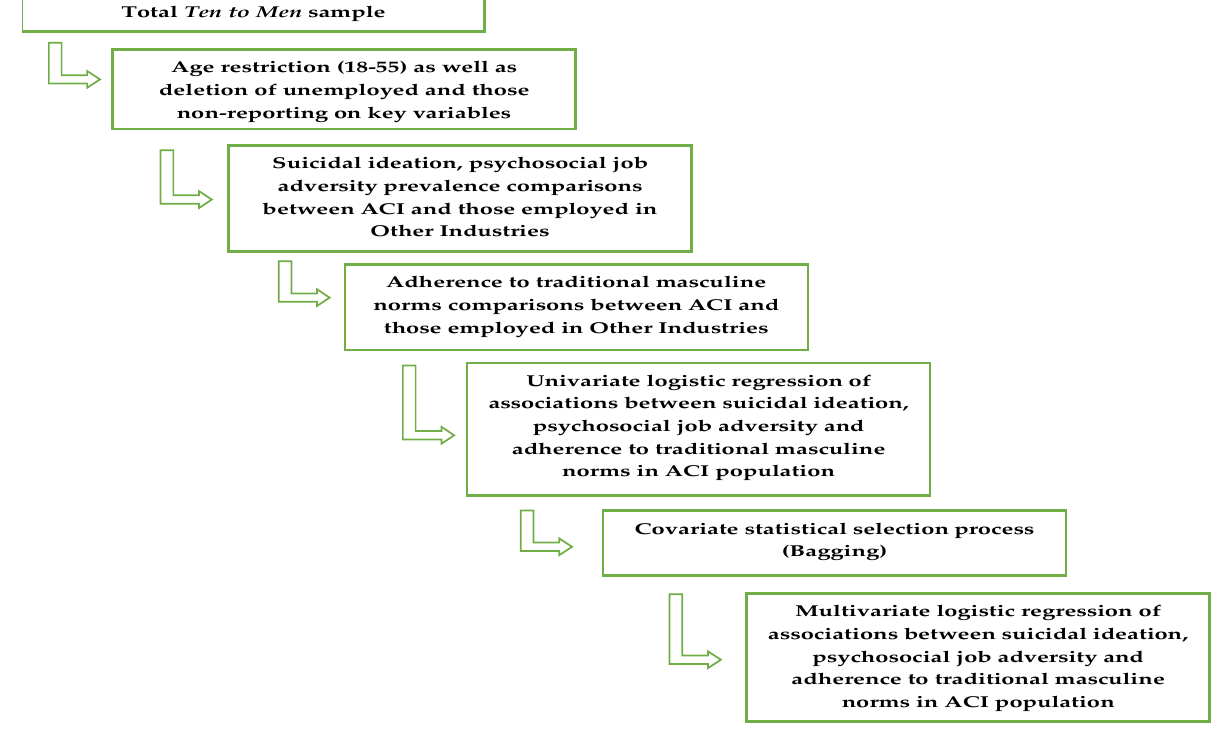
Figure 1. Methodology Flowchart .